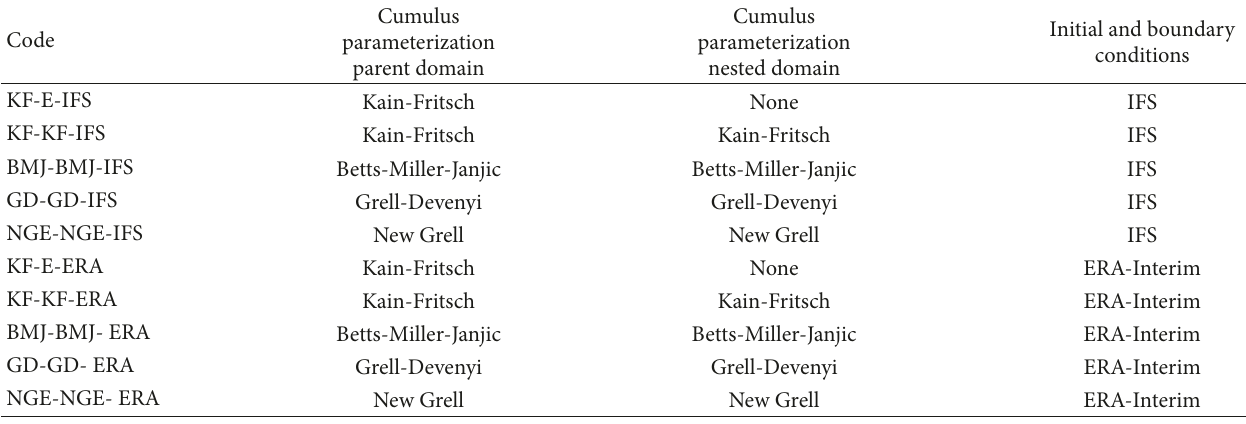
Table 2: Set of all ten model configurations explored in this study.